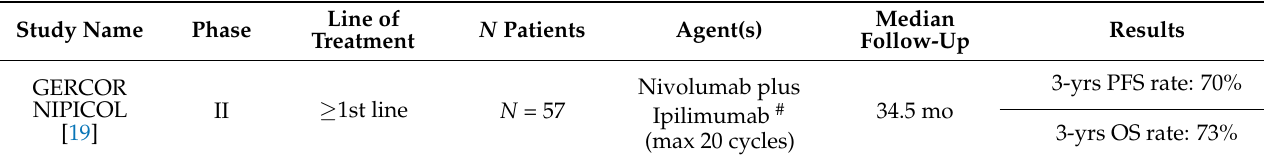
Table 1. Clinical trials with ICIs in dMMR/MSI-H mCRC